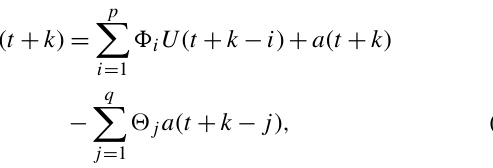
Figure 11. Histogram of the forecast errors (cid:15) for period 7 (neutral) for all evaluated models. The red line represents a normal distribution with the same mean µ and standard deviation σ as the distribution of